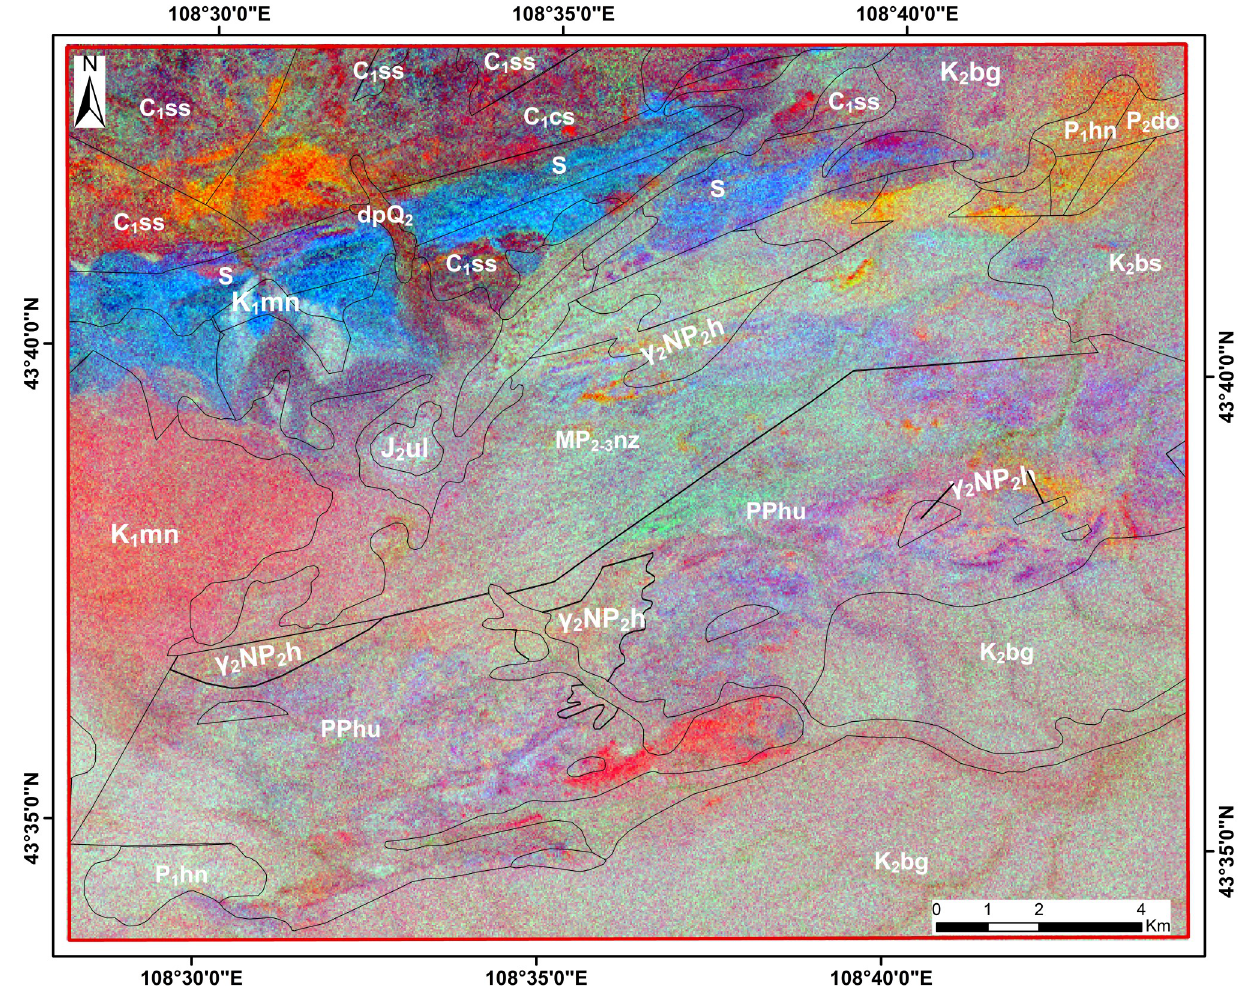
Fig. 11. False color composite image of ASTER: BRs (RGB: 7/6, 6/5,